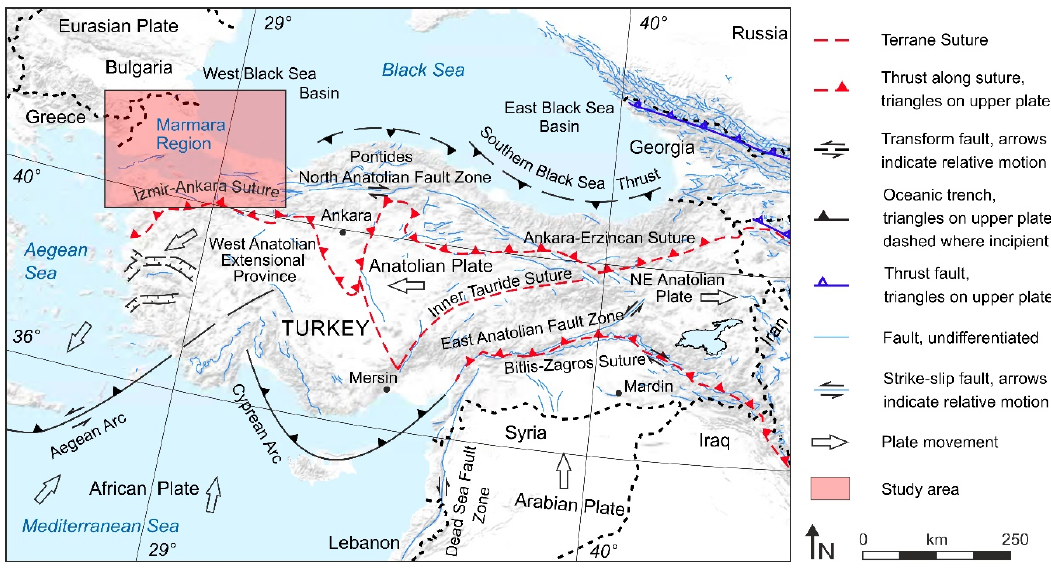
Figure 1. Simplified neotectonic map of Turkey and the surrounding (compiled with Okay and Tüysüz, 1999 [32]; USGS, 2010 [33]; Ekinci and Yi ğ itba ş , 2012 [34], 2015 [35]). The Marmara Region is located at the western end of the NAFZ. This right lateral fault is about 1600 km long and has produced significant earthquakes throughout history. Its general character is the presence of stress transfer, which starts from Karl ı ova (Bingöl) and progresses due to tectonic thrust towards the west. Large and devastating earthquakes (Mw > 7.0) occurred between 1939 and 1944 in the eastern part and between 1957 and 1999 in the western part on the NAFZ. After the last two earthquakes (Gölcük Mw = 7.4 and Kayna ş l ı Mw = 7.2) that occurred in the east of Marmara